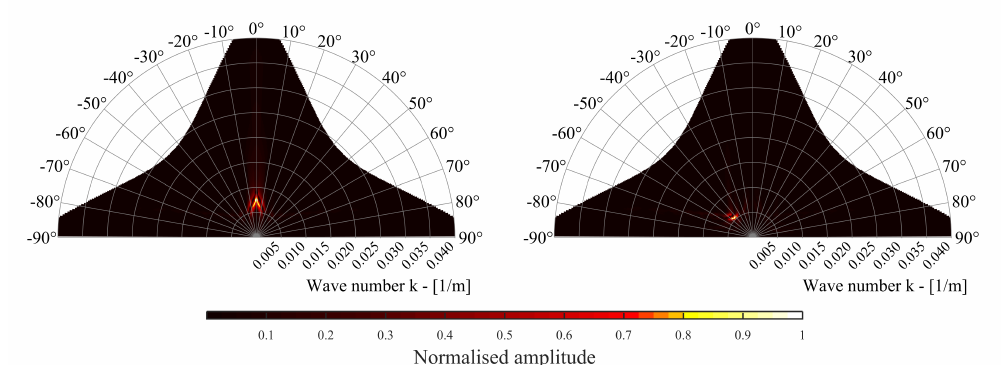
Figure 3. Normalized Radon-discrete fast-Fourier transform (DFT) wave number spectra for a wave in shore normal direction at the top and oblique ( − 45 deg) incident wave in the bottom. The wave number range is between 0 and 0.04 [1/m] with 0.001 [1/m] resolution, the circular bands indicate 0.005 [1/m] intervals. The direction ranges from − 90 to 90 with a ∆ θ of 0.5 degree, the spokes represent a 10-degree